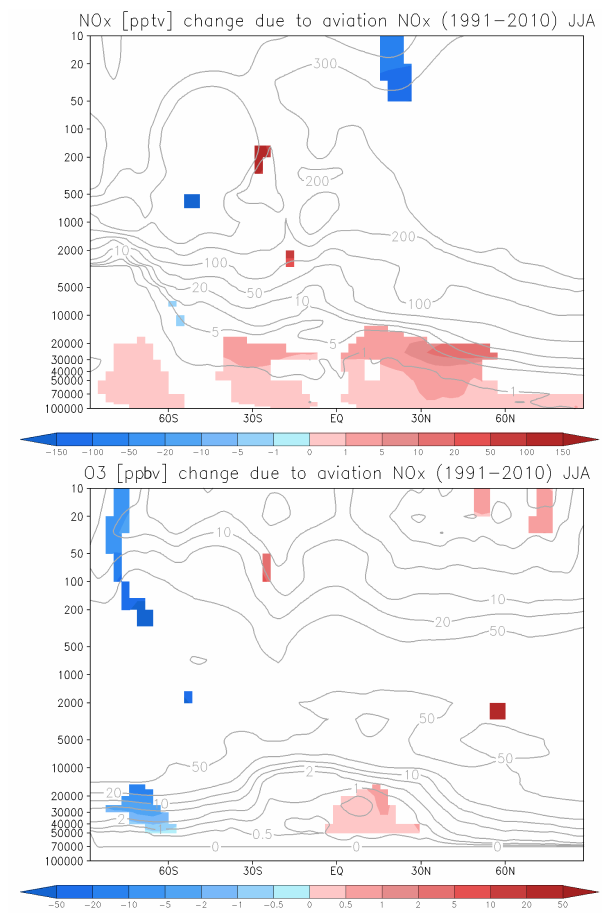
Fig. 13. The June–July–August impact of aircraft NO x emissions on the zonally averaged NO x (pptv) and O 3 (ppbv) distributions for 1991–2010 and the standard deviation of the difference calculated from the members (contour lines). The shaded areas show signifi- cant changes at the 95% level of confidence. The vertical axis cor- responds to pressure in Pa.